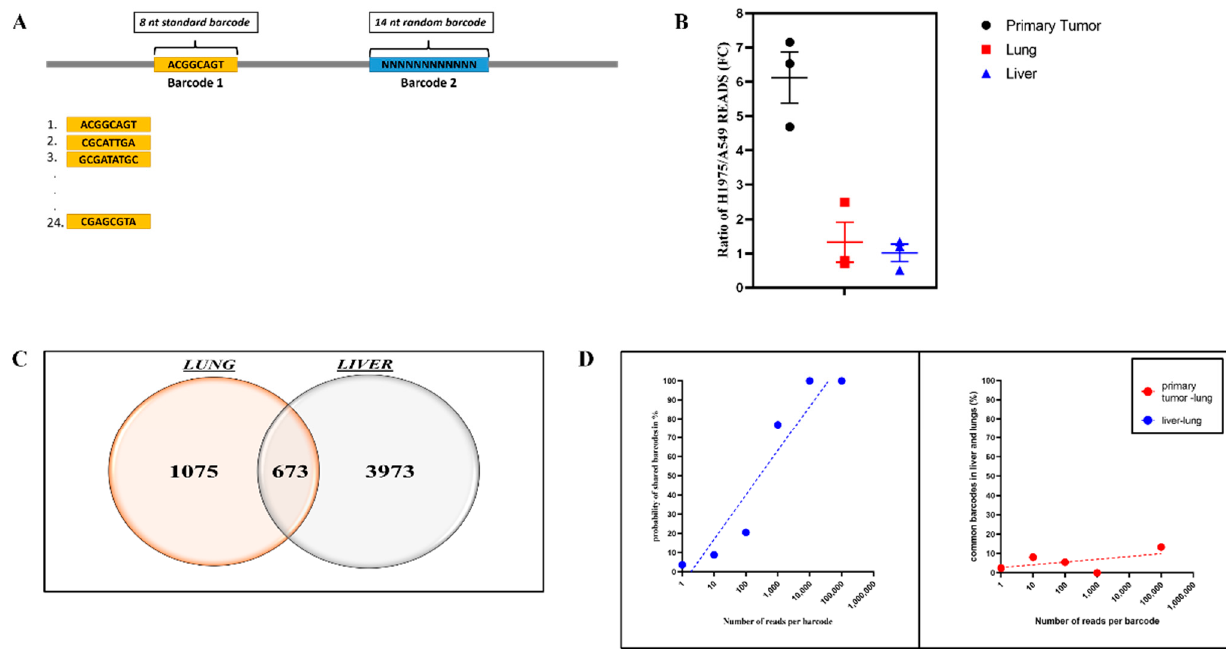
Figure 1. Double-cell barcoding system allows monitoring primary tumors and metastasis derived from several cell lines simultaneously. ( A ) The schematic representation of the double-barcoding system. ( B ) Metastatic ability of H1975 and A549 cell lines. The data reflect the fold change difference of the number of reads corresponding to H1975 and A549 cell lines in primary tumors and metastasis. ( C ) A significant fraction of clones that form metastasis in lungs can also form metastasis in liver. The number of barcodes common and unique for lungs and liver is shown. ( D ) The ability to form metastasis does not correlate with the growth of cells in primary tumors (right panel). However, the ability of clones to populate and grow in lungs closely correlates with the rate of growth in liver (left panel).